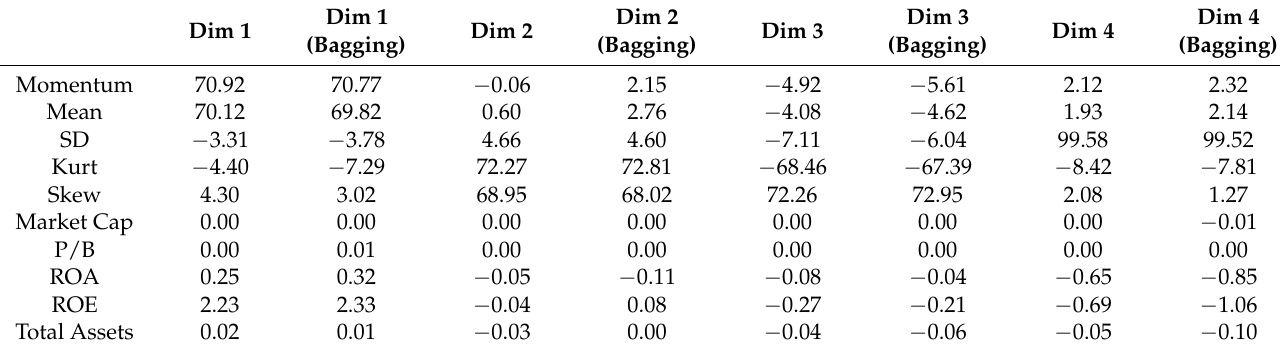
Table 3. Loadings computed with all the data vs. loadings computed by